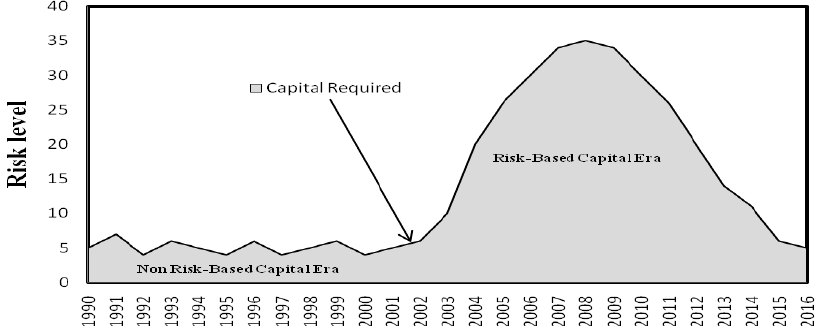
Figure 2. Simulation of a firm’s capital requirement. Source: Inference from Shimpi & Re (2002).